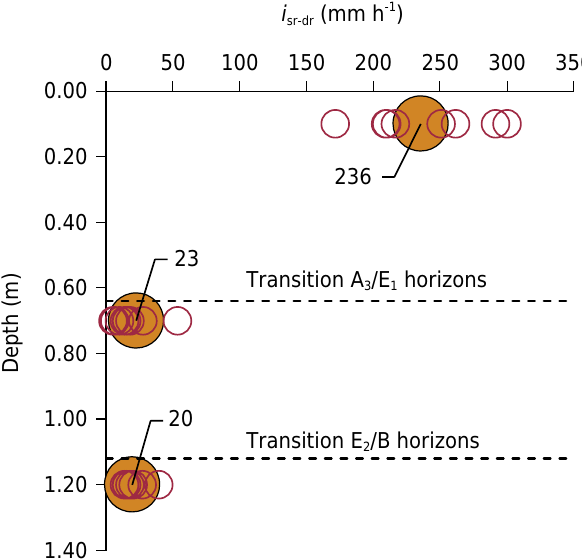
Figure 2. Steady infiltration rate measured with a double ring infiltrometer ( i sr-dr ) at the top of A 1 , E 1 , and B horizons in nine plots of a Typic Paleudult. Small circles represent individual measurements, larger circles the average value per horizon.